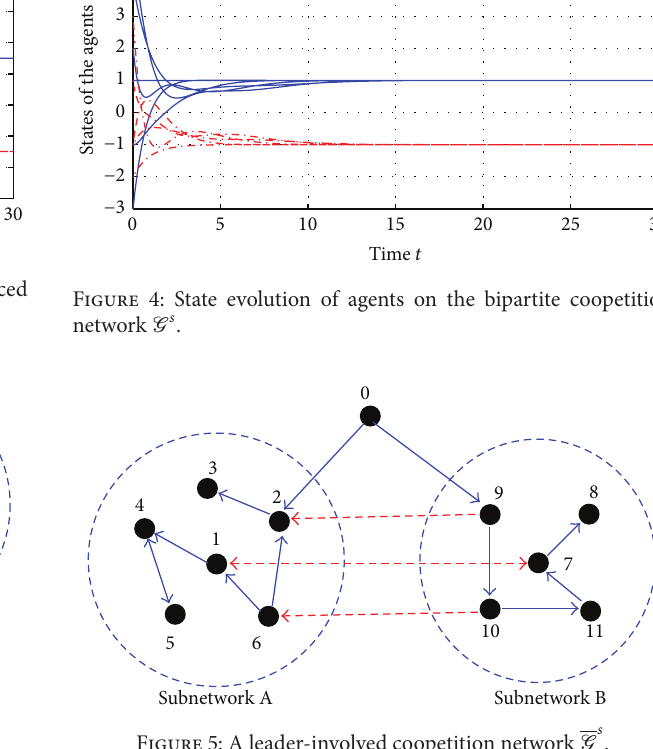
Figure 5: A leader-involved coopetition network G